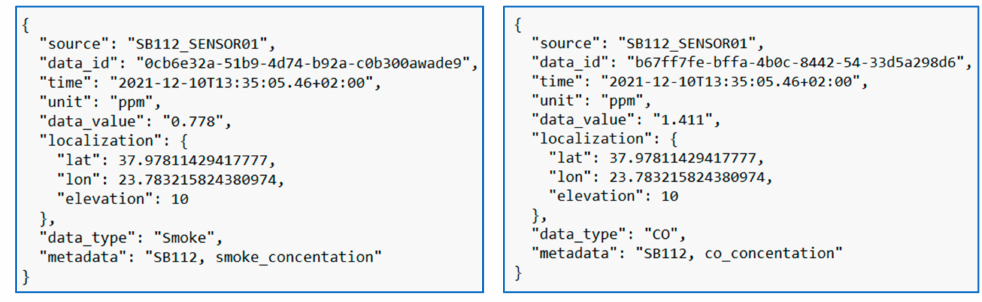
Figure 7. Verification that the smart city middleware (Apache Kafka) received the raw measurements of sensor node 1 from the DECIoT (( left ): smoke; ( right ): CO).